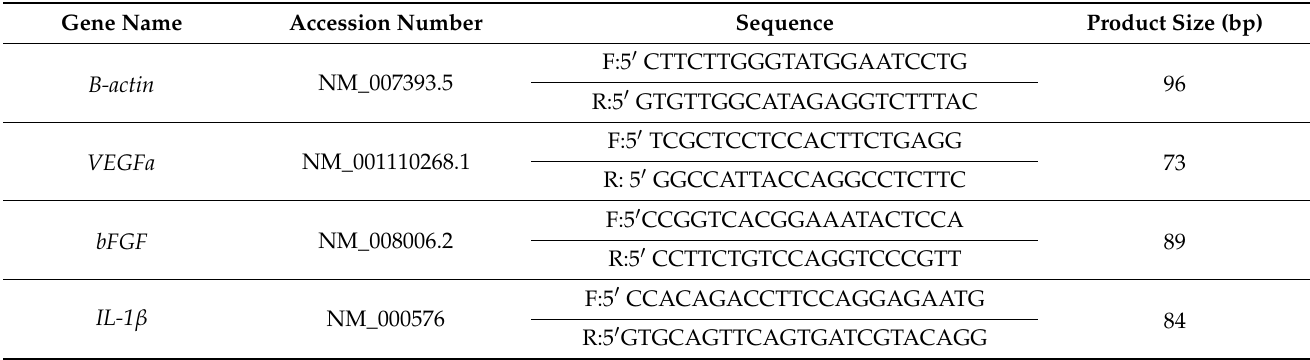
Table 1. The primer